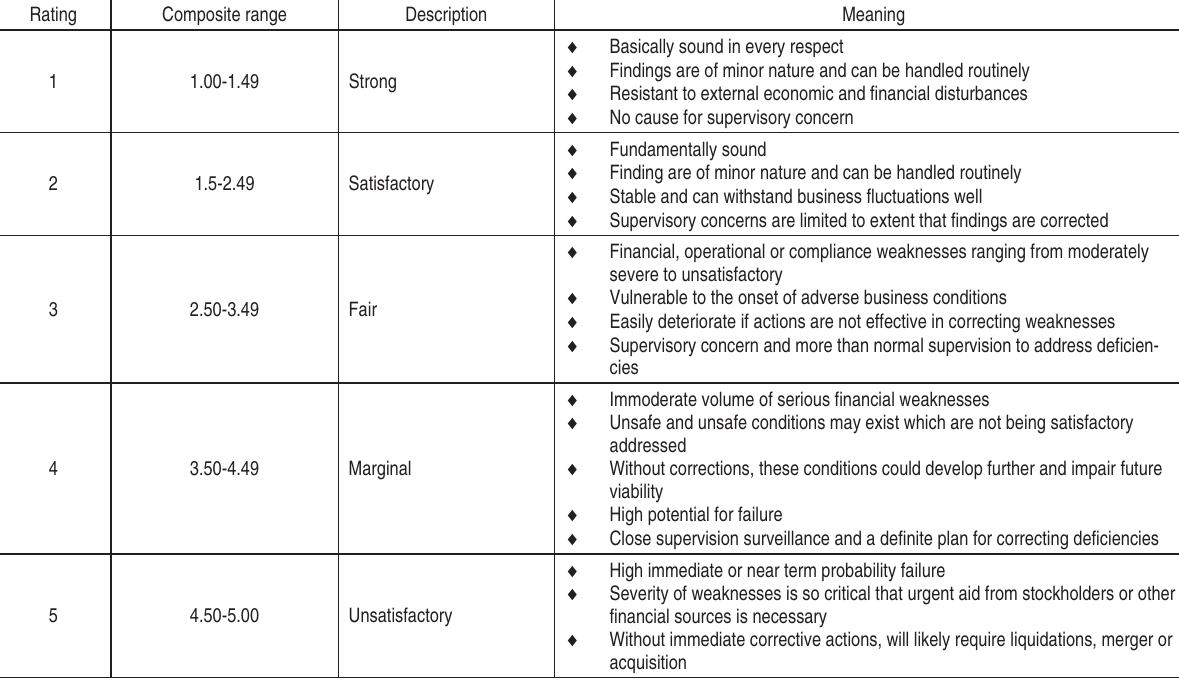
Table 2. Composite range of CAMELS rating (Heldek, 2010; Wirnkar and Tanko, 2008; Sarker,